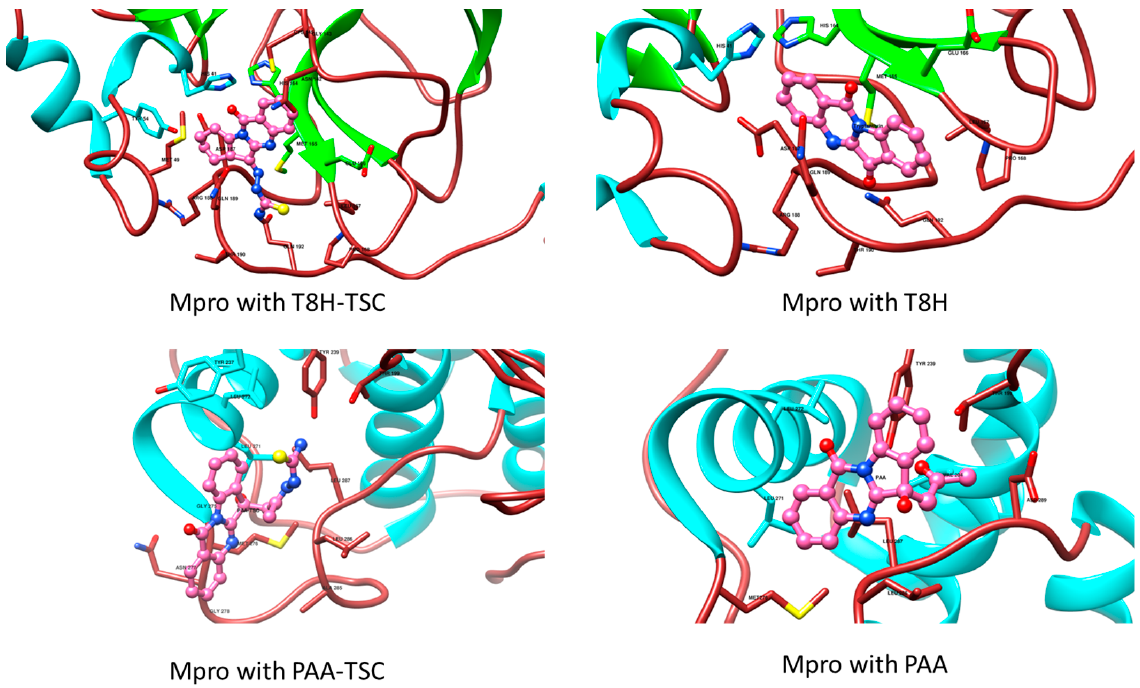
Figure 18. Comparison of Mpro with tryptanthrin derivates (TSC compounds, the left side of figure) with tryptanthrin and PAA (right side). During the creation of the magnified image, the hydrogen atoms were hidden for aesthetic reasons.